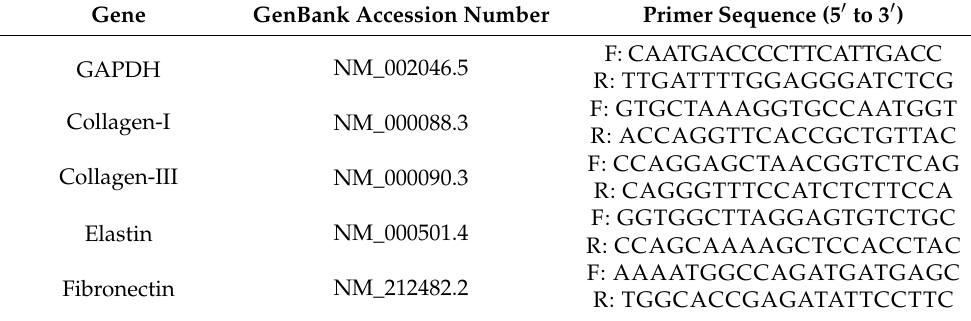
Table 2. Forward and reverse primer sequences of ECM markers and housekeeping gene. Gene GenBank Accession Number Primer Sequence (5 (cid:48) to 3 (cid:48)